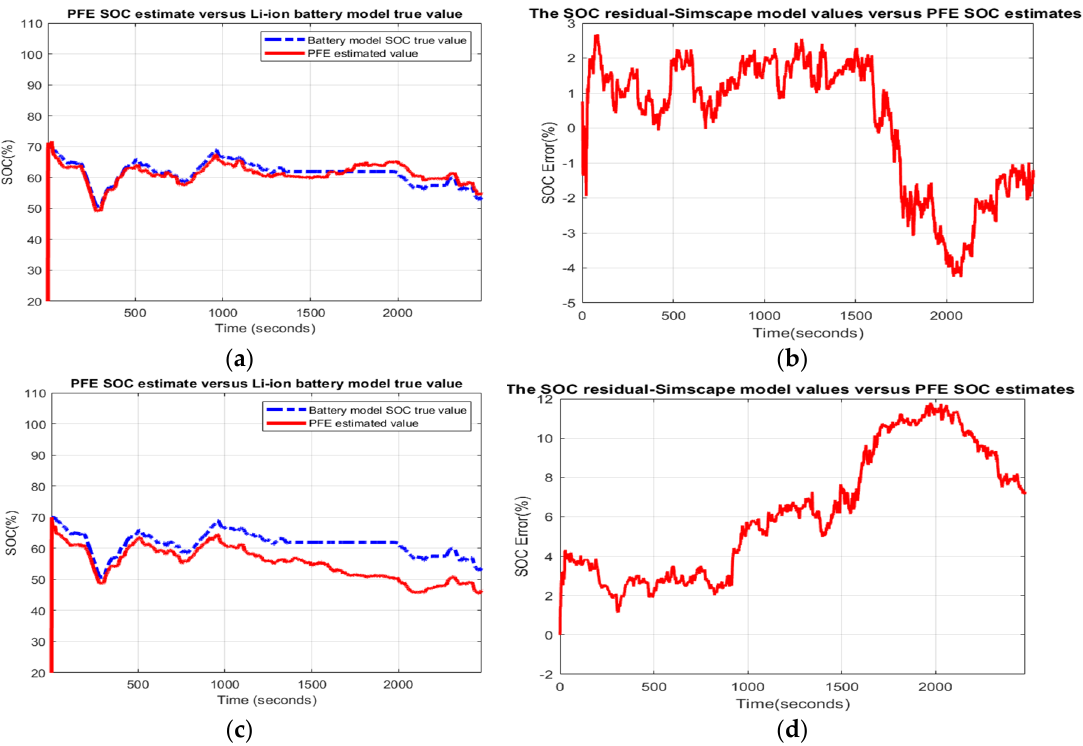
Figure 13. Robustness to simultaneous changes, SOCini = 0.2, and output temperature profile changes; ( a ) PFE SOC value versus battery model true value for changes only in Kp; ( b ) SOC residual for changes only in Kp; ( c ) PFE SOC value versus battery model true value for 10% changes only in Rin; ( d ) SOC residual for changes only in Rin.